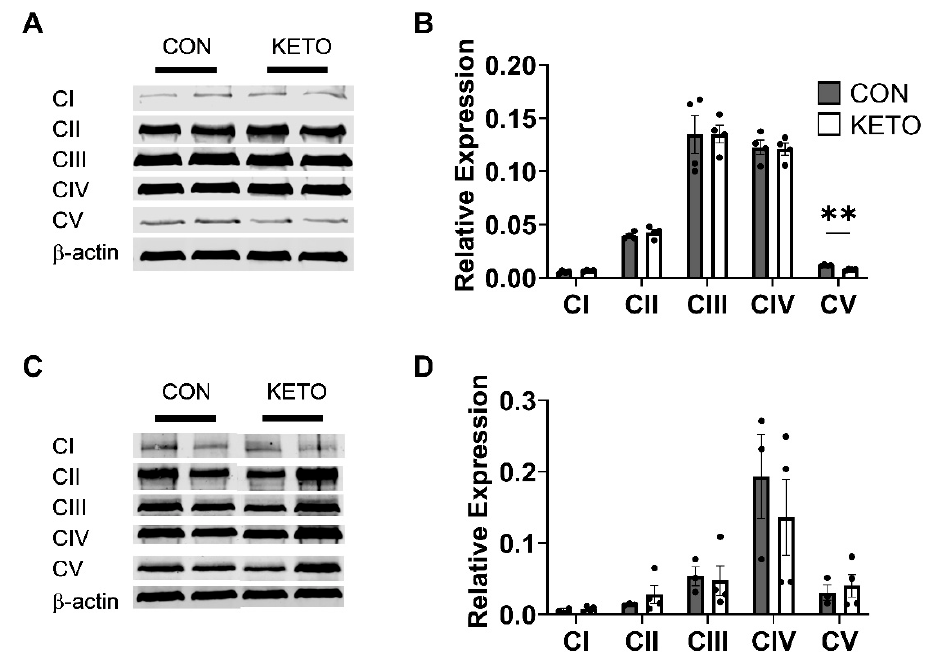
Figure 4. Ketogenic diet significantly reduces complex V expression in female mice. Representative Western blots against mitochondrial complexes I–V in ( A , B ) female (CON, n = 4; KETO, n = 4) and ( C , D ) male (CON, n = 3; KETO, n = 4) mice and their relative expression. ** p < 0.01.